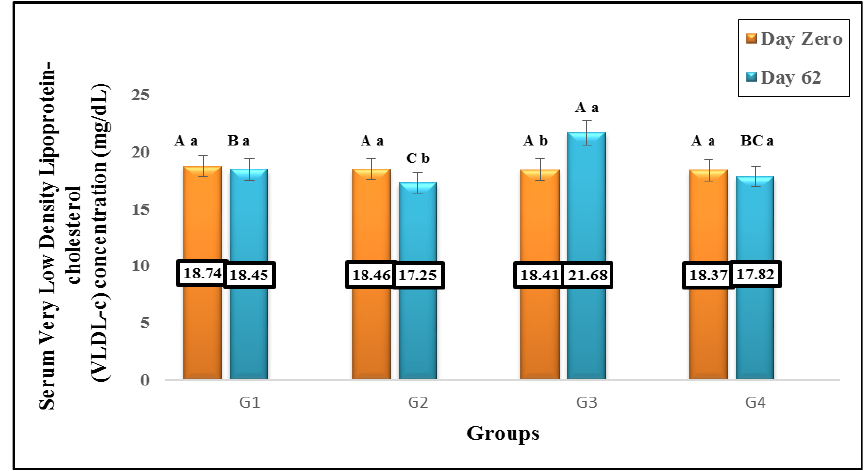
Figure 3. Effect of phosphatidylcholine, fructose and/or combination on serum very low density lipoprotein-cholesterol (VLDL-c) concentration (mg/dL). Mean ± SE, n = 9 in a group. G1 control groups (C), G2: (Pc), G3: (Fr), G4: (Fr + Pc). A-C Significant variations P ≤0.05 between peroids